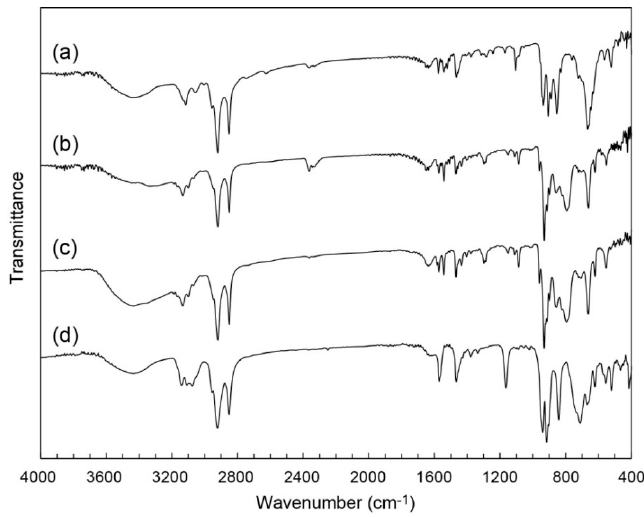
Figure 2. Infrared (IR) spectra of C 12 im-Mo hybrids: (a) C 12 im-Mo hybrid ( 1 ) obtained from C 12 im-N; (b) C 12 im- δ -Mo 8 ( 2 ) obtained from C 12 im·Cl; (c) 2 after recrystallization; (d) C 12 mim- β -Mo 8 ( 3 ) obtained by using C 12 mim.